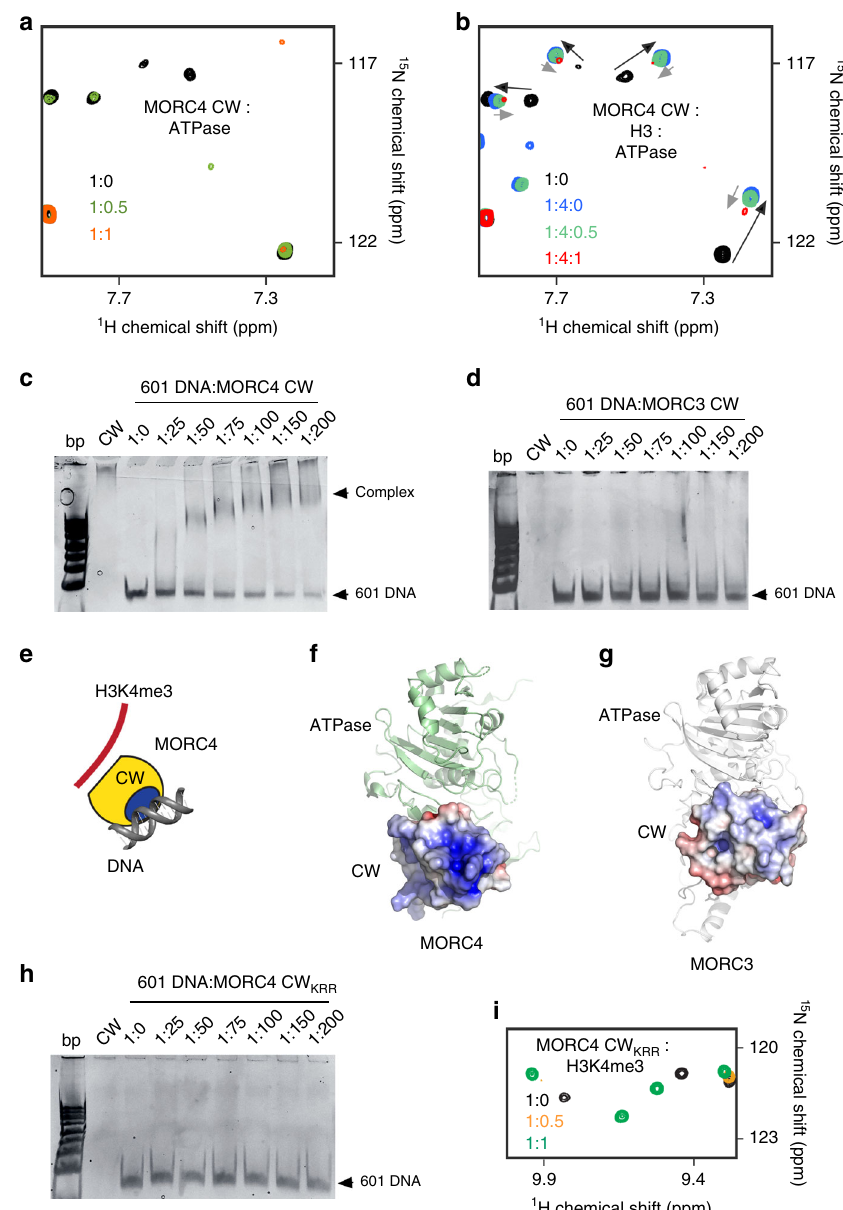
Fig. 3 MORC4 CW binds to DNA. a Superimposed 1 H, 15 N HSQC spectra of the 15 N-labeled MORC4 CW domain collected upon titration with the unlabeled ATPase domain of MORC4. b Superimposed 1 H, 15 N HSQC spectra of the 15 N-labeled MORC4 CW domain (in complex with H3 peptide) collected upon titration with the unlabeled ATPase domain. Spectra in ( a , b ) are color coded according to the protein-to-ligands molar ratio. ( c , d ) EMSA with 601 DNA in the presence of increasing amounts of MORC4 CW ( c ) and MORC3 CW ( d ). e Cartoon representation of MORC4 CW in complex with histone H3K4me3 tail and DNA. f , g Electrostatic surface potential of the CW domain of MORC4 ( f ) and MORC3 ( g ) (within the ATPase-CW cassette) was generated using APBS in Pymol with a range of – 5/5 kT/e and colored blue and red for positive and negative charges, respectively. The ATPase domain is shown as ribbon and colored green and white in MORC4 and MORC3, respectively. The missing loops (residues K441 and R463) in the model of MORC4 CW were completed for this fi gure. h EMSA with 601 DNA in the presence of increasing amounts of mutant MORC4 CW KRR . i Superimposed 1 H, 15 N HSQC spectra of the 15 N-labeled MORC4 CW KRR domain collected upon titration with the histone H3K4me3 peptide. Spectra are color coded according to the protein-to-peptide molar